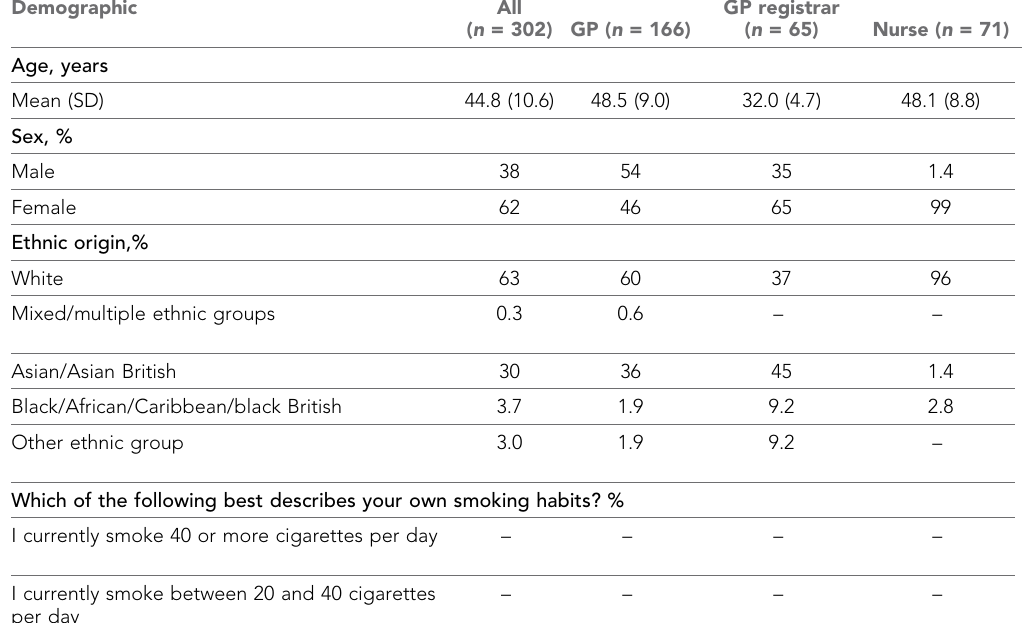
Table 1. Demographics, health behaviours and knowledge for responders, by professional